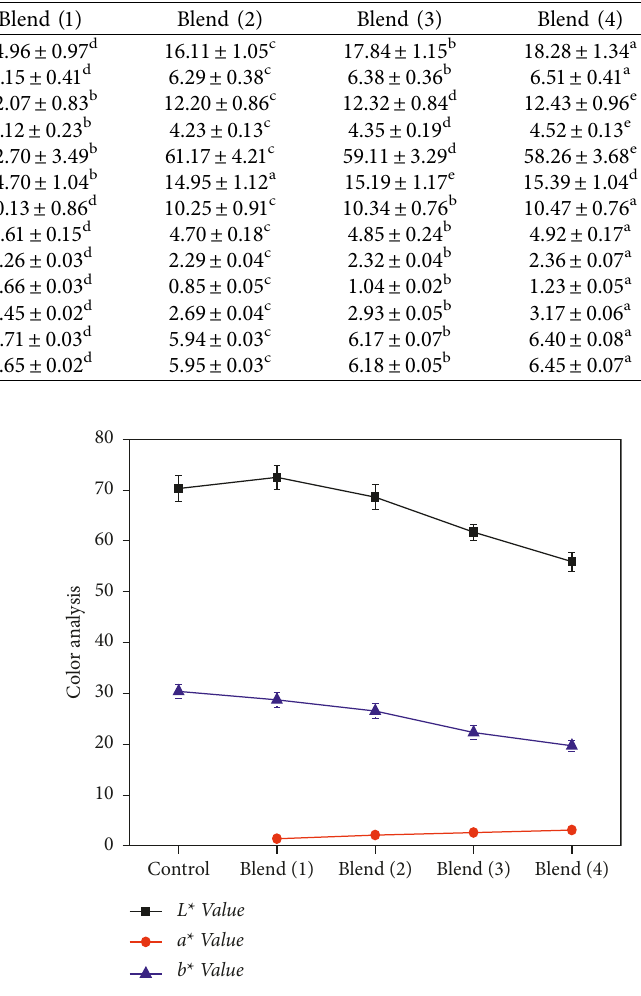
Figure 4: Color analysis of multigrain pan bread. (L ∗ ): lightness& darkness, (a ∗ ): redness & greenness, and (b ∗ ): yellowness & blueness.